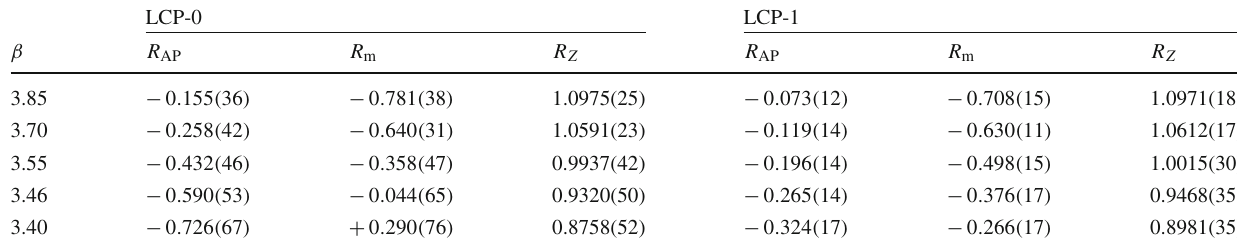
Table 4 Interpolated values of our estimators for couplings employed in CLS simulations along the two renormalised trajectories LCP-0 and LCP-1 considered in this work. Statistical uncertainties are as described in the text and match the confidence band in Fig. 7 LCP-0